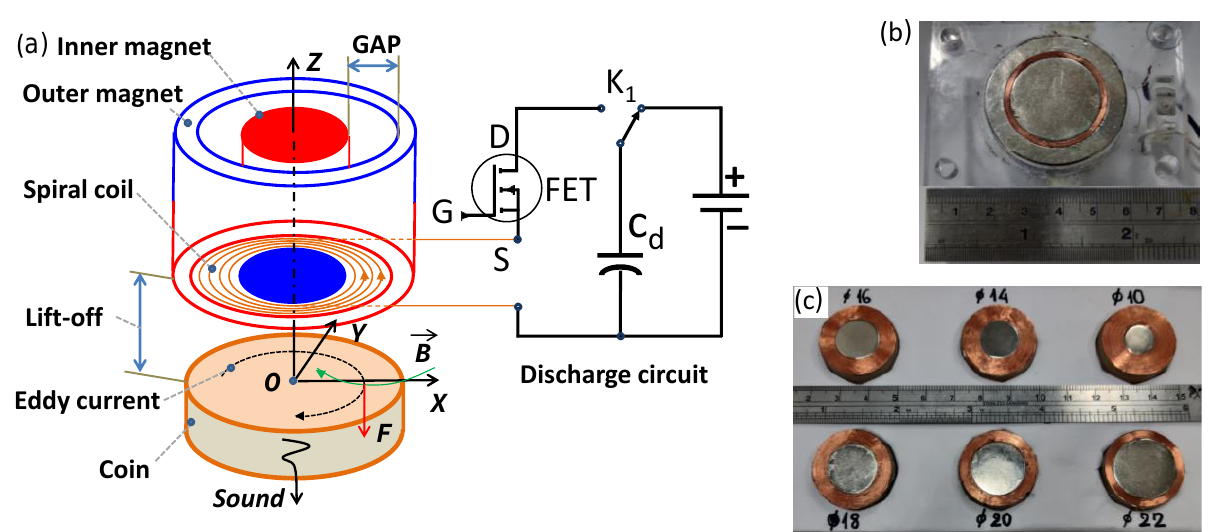
Figure 1. The experimental coin identification system based on an electromagnetic acoustic transducer (EMAT) and a microphone receiver: ( a ) functional diagram, ( b ) photograph of the system.